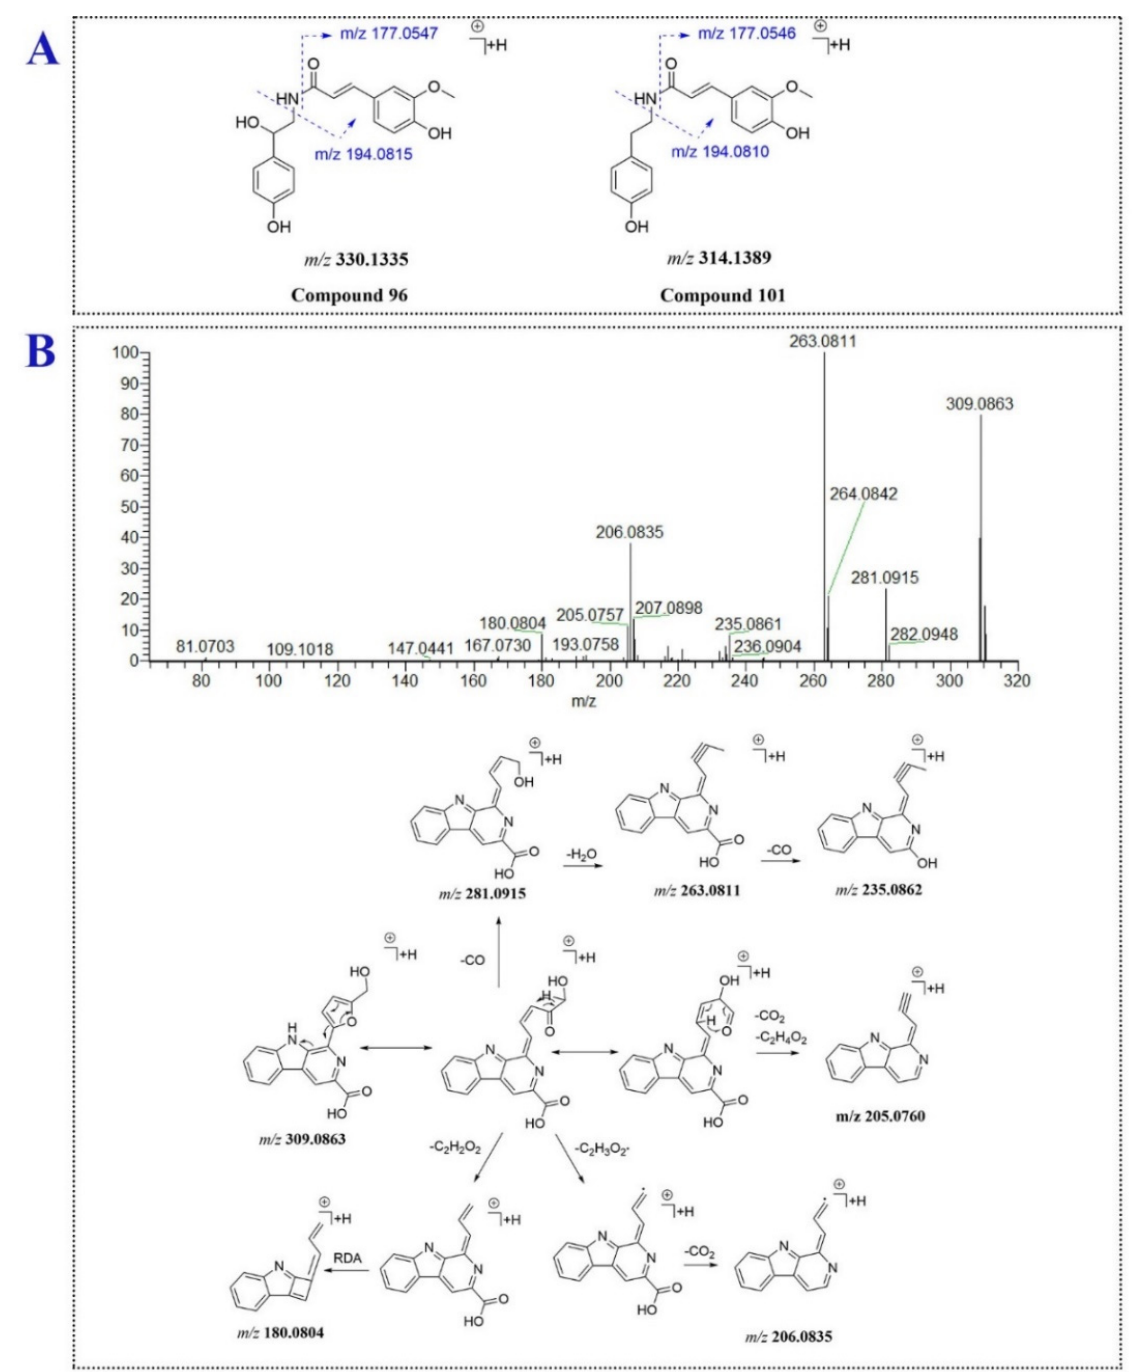
Figure 5. The fragmentation patterns of compounds 96 , 101 ( A ) and 106 ( B